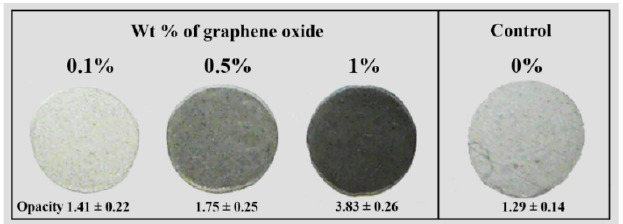
Figure 3. Film composite structures formed by calcium alginate and graphene oxide (GO). Increasing concentrations of GO in the range of 0–1% w / w . The opacity is presented as mean ± standard deviation in the base part of the samples. Reprinted with permission from Elsevier [71].